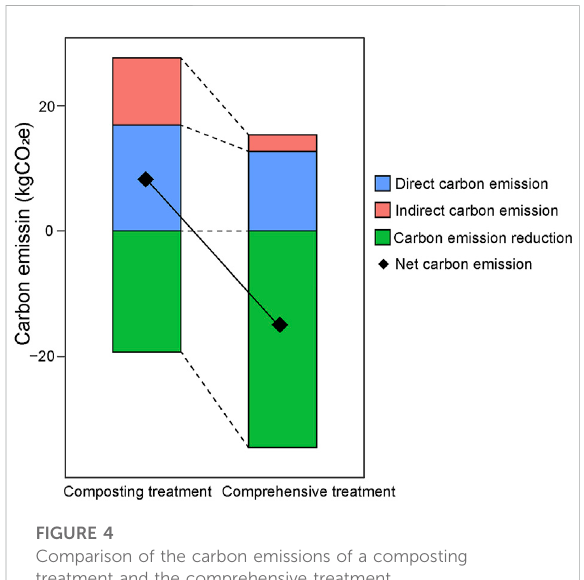
FIGURE 4 Comparison of the carbon emissions of a composting treatment and the comprehensive